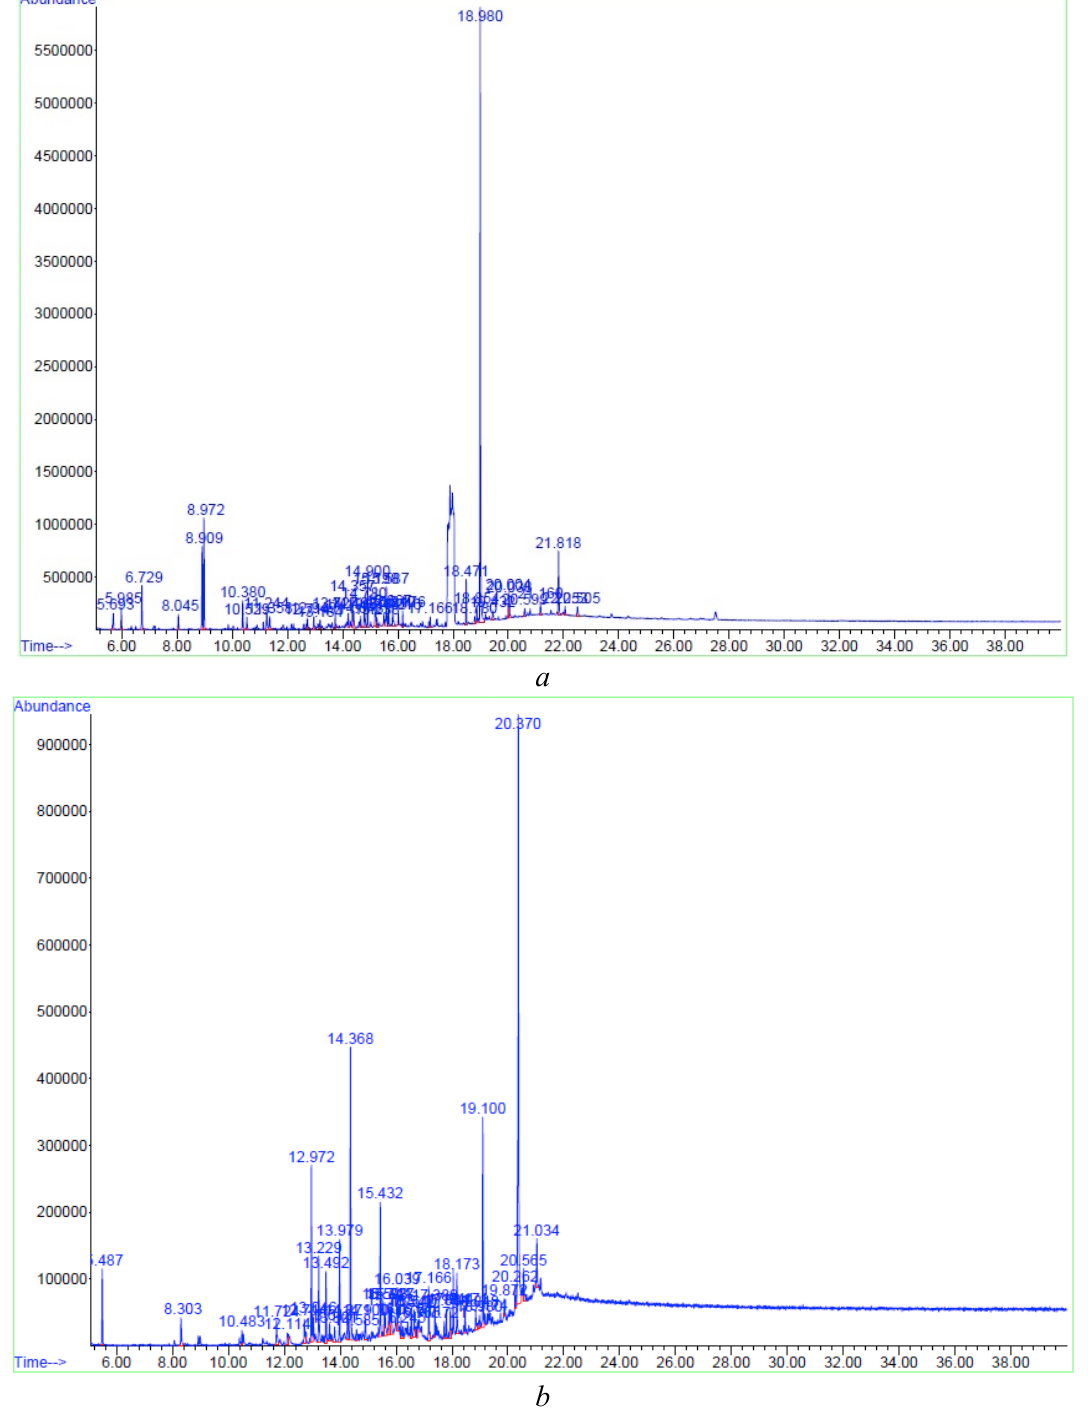
Fig. S5: GS-MS chromatogram of leaves ( a ) and fruits ( b ) of essential oil of F. viridis Weston from sample V